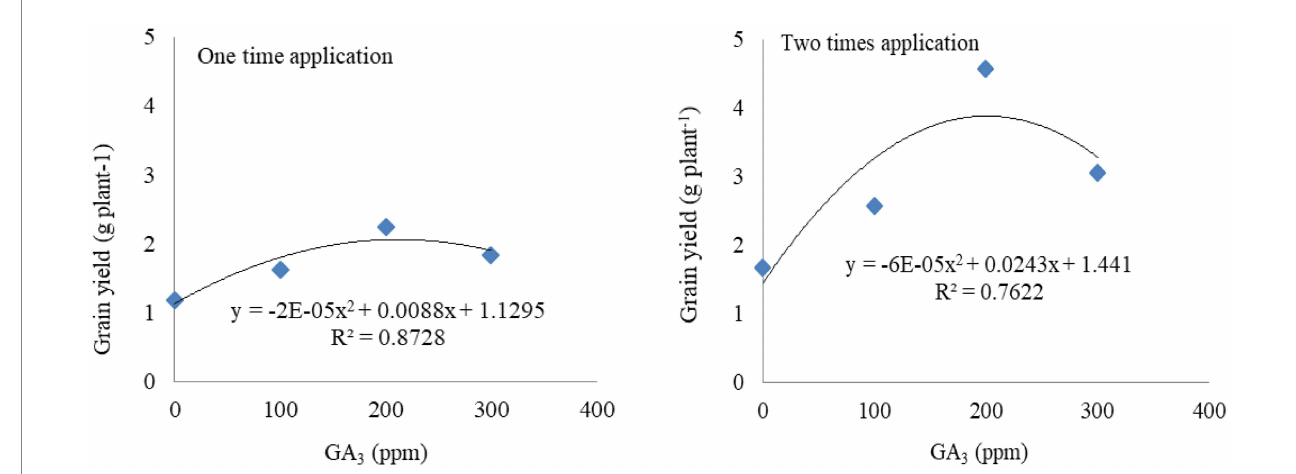
FIGURE 2 Functional relationship between GA 3 (concentrations and frequencies) and grain yield of mungbean.